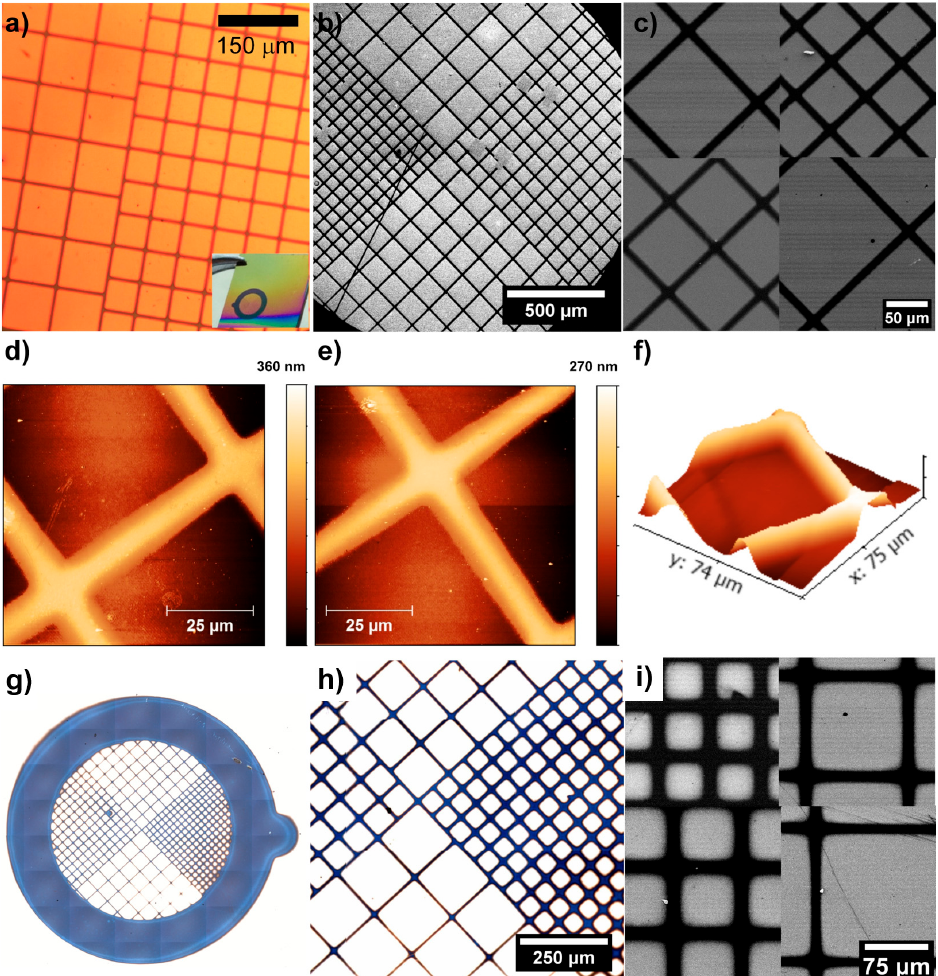
Figure 5. Patterns of polymer brushes obtained by ( a–f ) direct and ( g–i ) remote photocatalytic lithography. Reproduced by permission of The Royal Society of Chemistry from ref. [39].